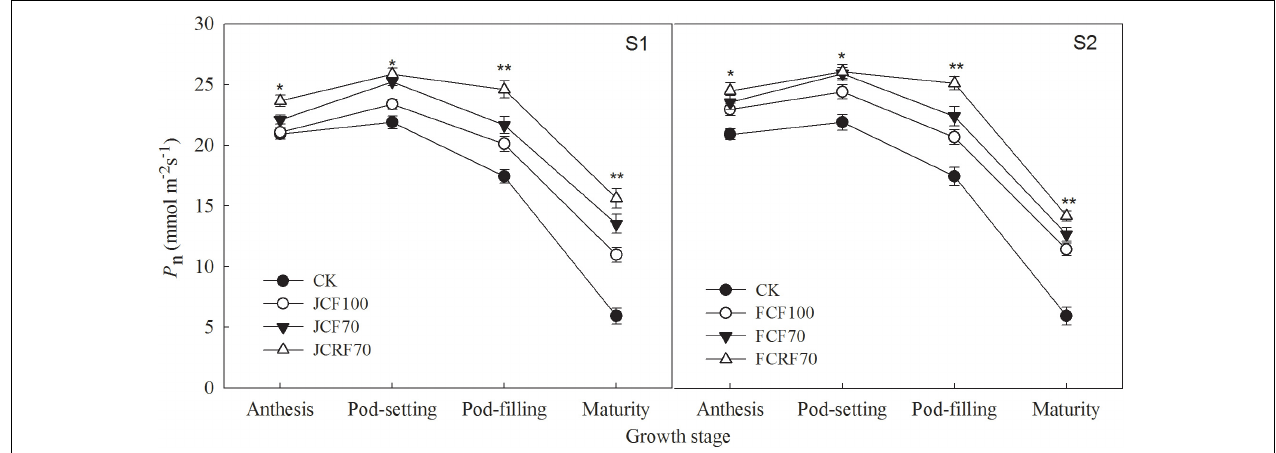
FIGURE 3 | Effect of different N fertilizer management regimes on the net photosynthetic rate ( P n ) of peanut. Abbreviations as in Figure 2 . Means and standard errors based on three replicates are shown. NS, not significant; ∗ significant at the 0.05 probability level; ∗∗ significant at the 0.01 probability level.